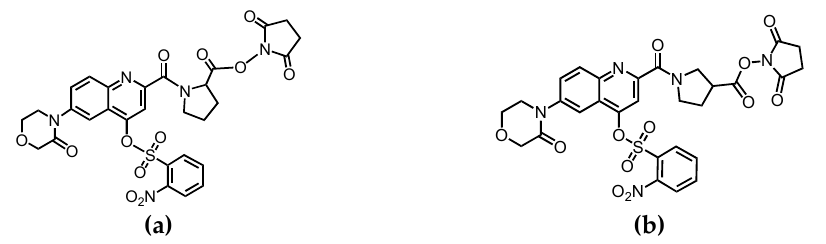
Figure 1. Chemical structure of Ns-MOK-Pro-OSu ( a ) and Ns-MOK- β -Pro-OSu ( b ). The time-course profile showing the progress of the reaction with certain amino acids was examined and compared with that of Ns-MOK- β -Pro-OSu. The mass fragmentation patterns of some amino acids and Tau derivatized with Ns-MOK- β -Pro-OSu in collision cells were examined.